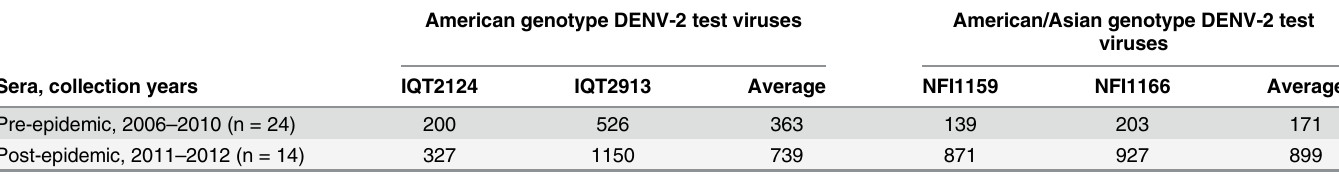
Table 3. Neutralization of Am-DENV-2 and AA-DENV-2 test viruses using human serum from longitudinal cohort studies. Geometric mean titers (GMTs) for the individual test viruses and the average of the two GMTs are